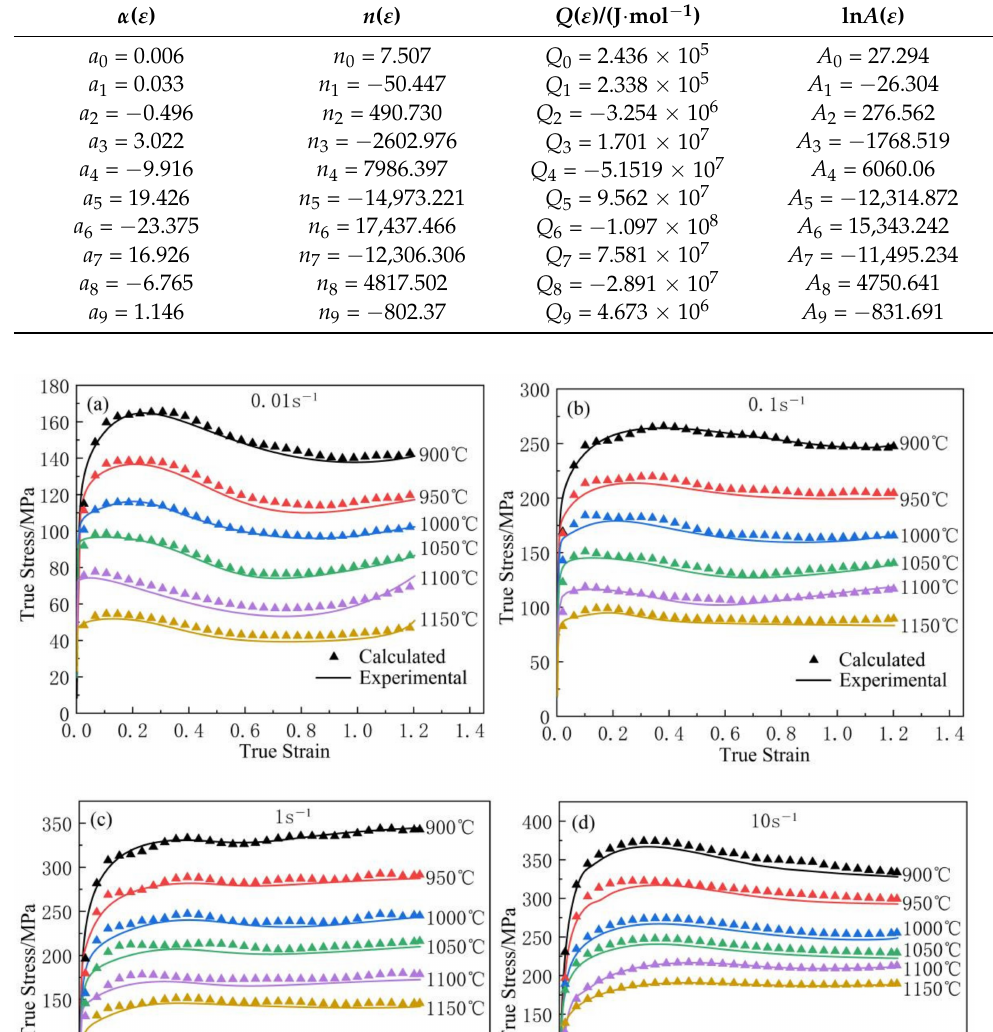
Table 2. Polynomial fitting results of α , n , Q, and ln A .